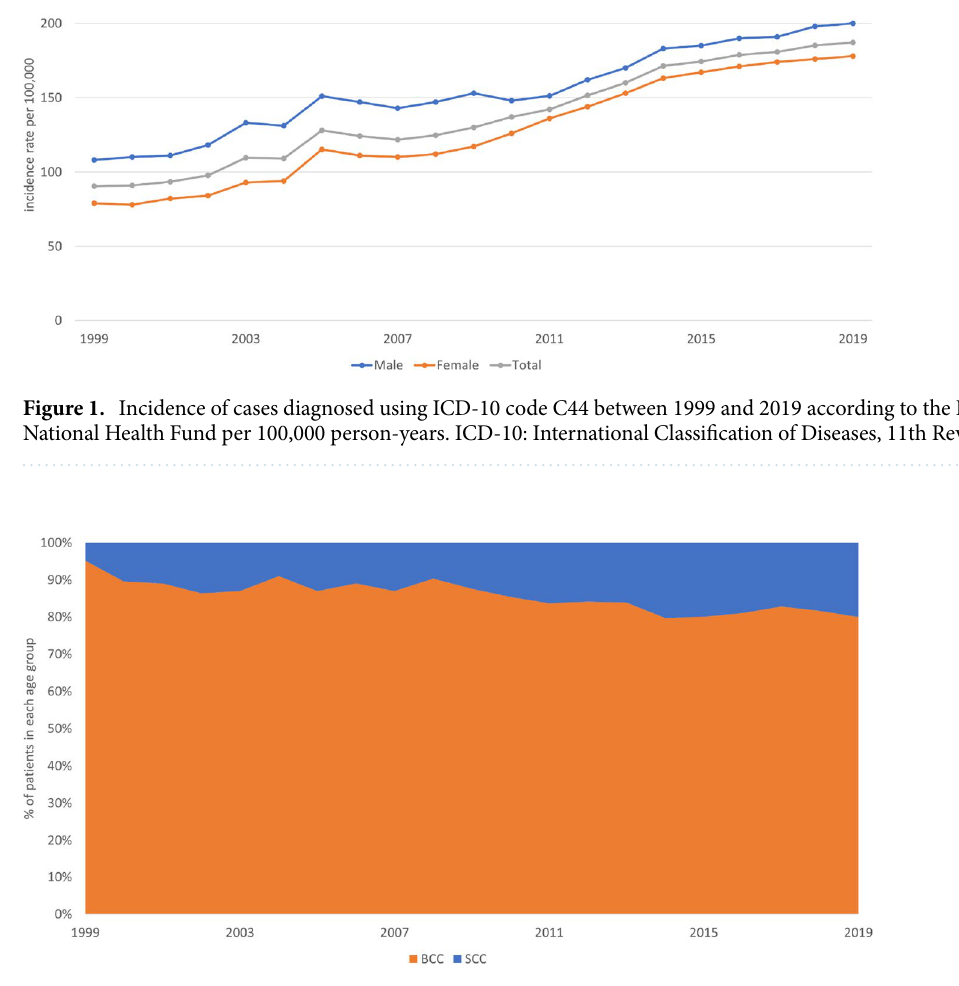
Figure 2. Annual BCC to SCC ratio between 1999 and 2019.